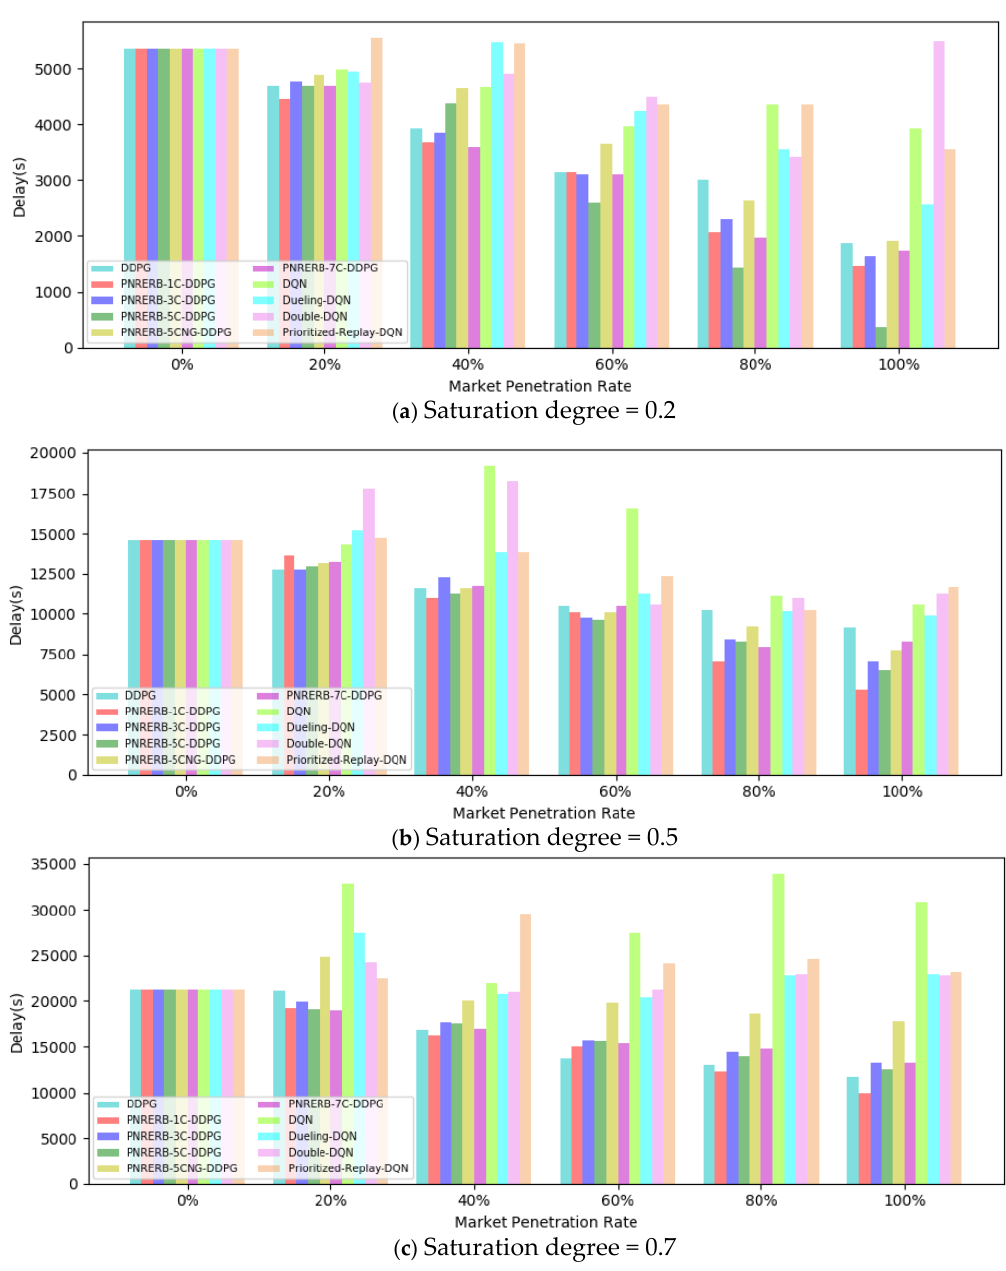
Figure 9. Comparison diagram of delay under different CAV MPRs under saturation degrees of 0.2/0.5/0.7.